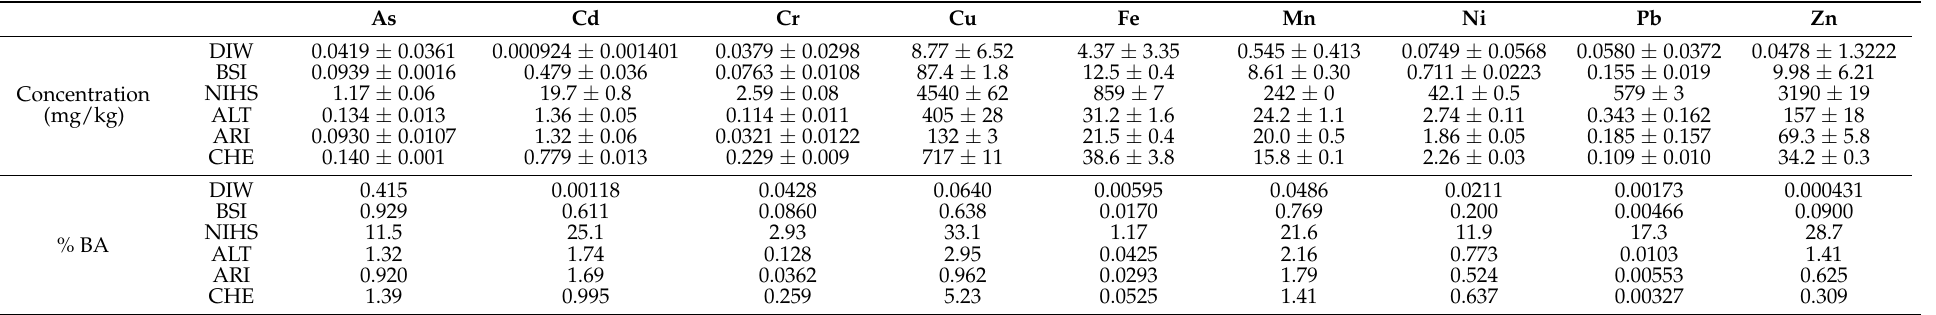
Table 4. Bioaccessible analyte concentrations obtained using five artificial sweat formulations at 37 ◦ C, together with % bioaccessibility values. As Cd